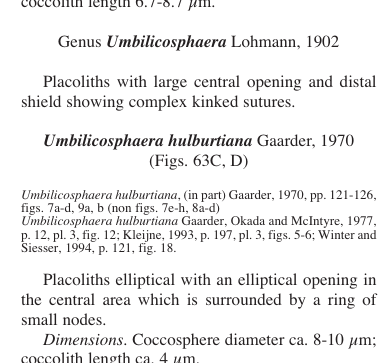
The coccosphere consists of a large number of coccoliths. Placoliths circular with a large circular central opening; distal shield equal to, or slightly narrower, than the proximal shield. The three collapsed coccospheres have 84, 94 and 124